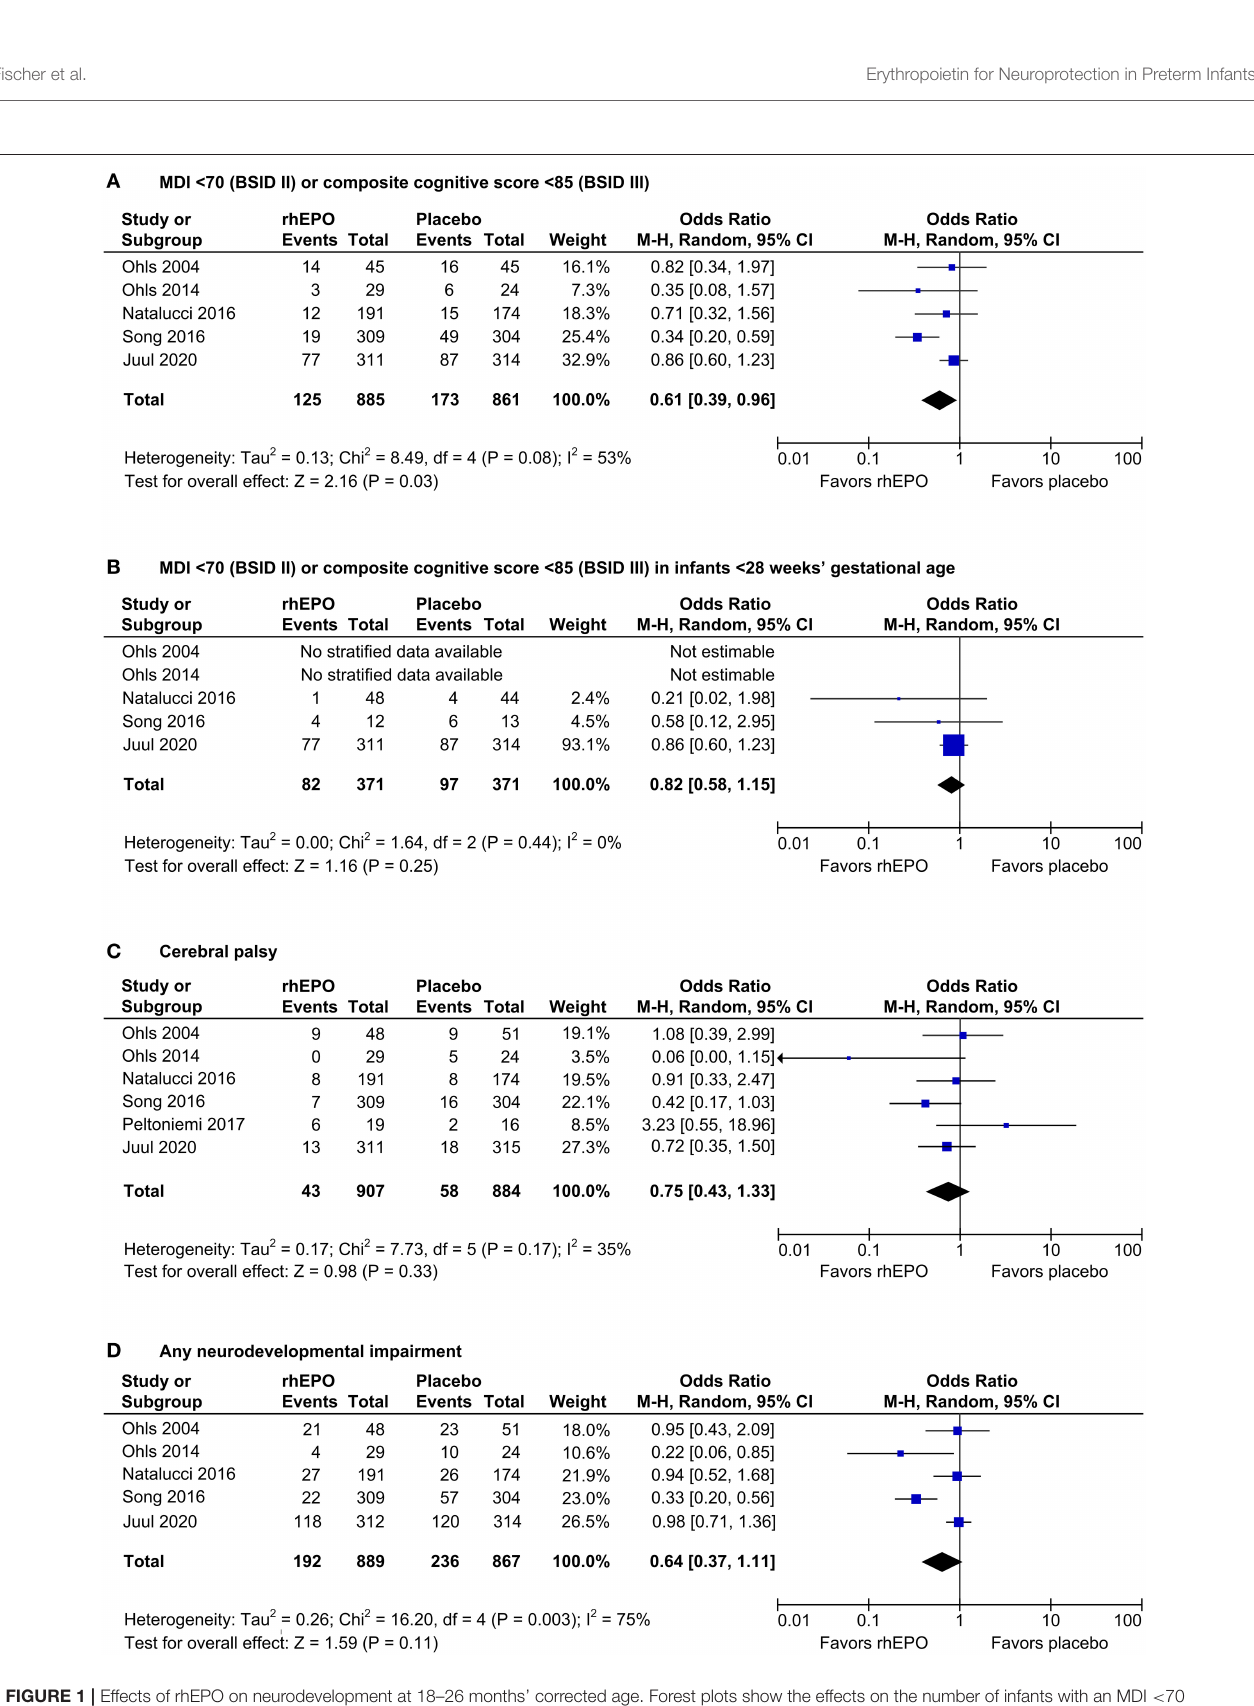
Frontiers in Pediatrics |